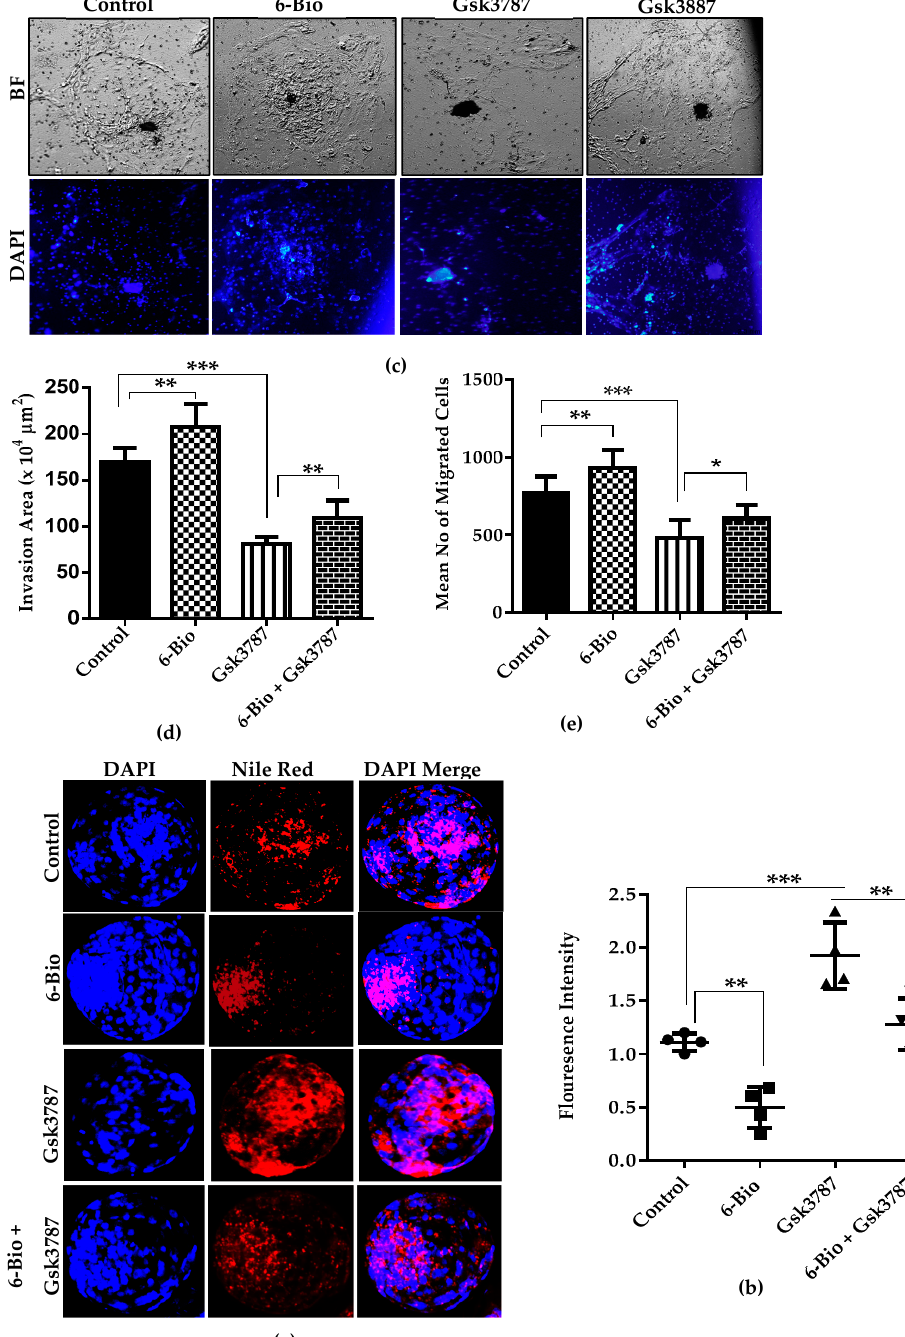
Figure 6. The effect of Wnt activation on lipid accumulation and invading ability of BL trophectoderm cells. (a) Fluorescent Nile probe (red) staining in control, Wnt agonist (400 nM), PPAR δ antagonist (15 µM) and combination of agonist + antagonist treated groups. (b) Quantification of mean fluorescence intensities shown in the graph. (c) Bright field images showing the invasion area of BLs cultured in 6-Bio, Gsk3787 and 6-Bio + Gsk3787 supplemented medium. (d) Representative bar graph shows the mean invasion area analyzed by image J software. (e) Bar graph present the mean number of migrated cells. Nuclei are stained in blue in all images. Data presented as means ± SEM from triplicate sets of experiment, including n = 20 BLs per group in each replicate. * p < 0.05; ** p < 0.01; *** p < 0.001 indicates significant di ff erence. Original magnification 100 ×